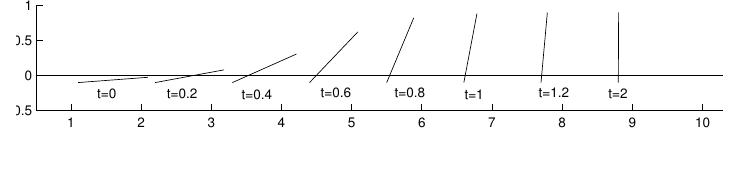
Figure 1. Unphysical situation: fiber penetrates the wall y = 0 according to Jeffery’s model. the stress stored in the fibers σ is a function of the rate of deformation tensor ˙ γ and the local fiber orientation distribution ψ = ψ ( p, x, t ), with the